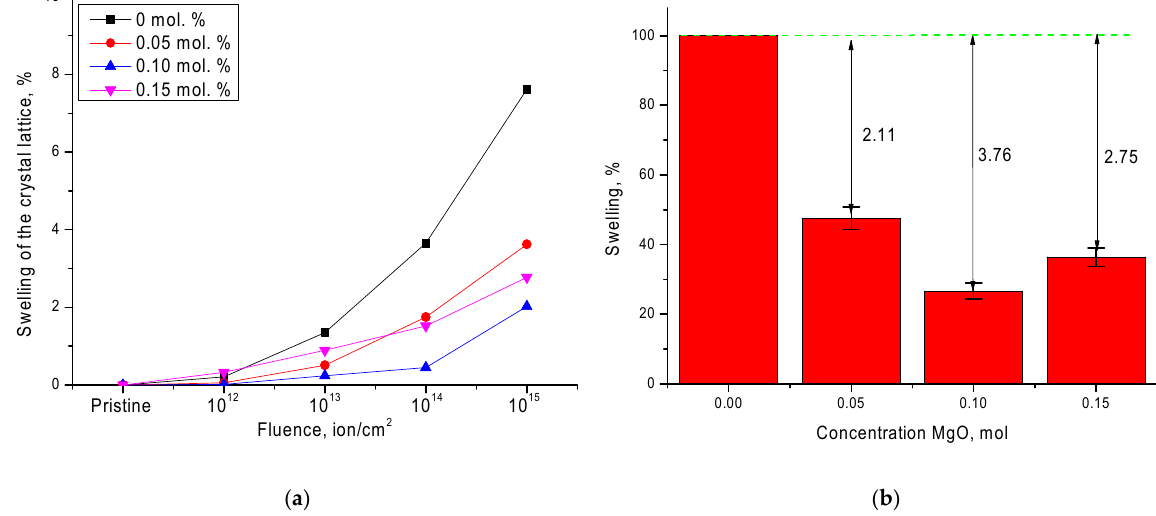
Figure 4. ( a ) Swelling of the crystal lattice of ceramics depending on the irradiation fluence; ( b ) comparative diagram of the swelling resistance of doped ceramics at maximum irradiation fluence (10 15 ion/cm 2 ).